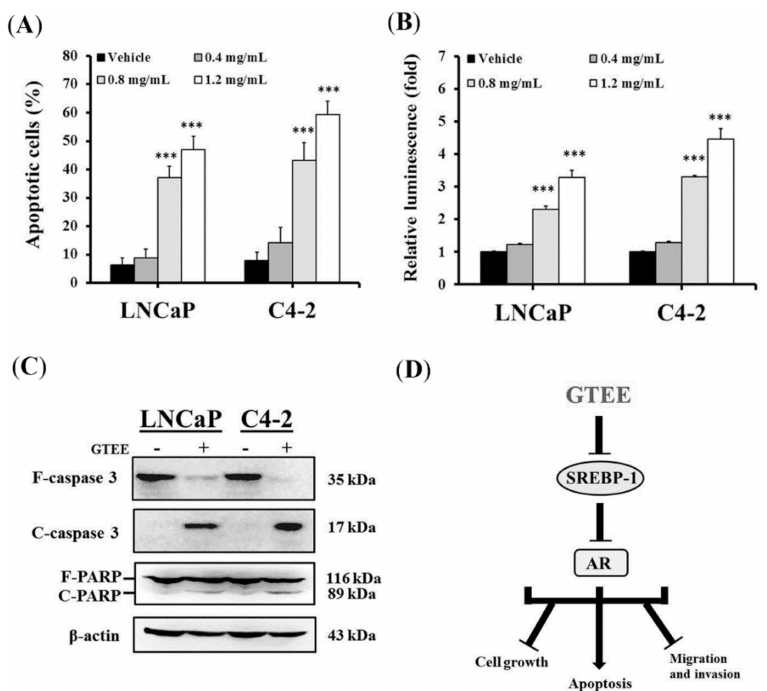
Figure 5. GTEE induces apoptosis through the caspase-dependent pathway in PCa cells. ( A ) After 24 h treatment with the vehicle (0.3% ethanol) or GTEE (0.4, 0.8 or 1.2 mg/mL), apoptotic cells (%) of LNCaP and C4-2 were determined by Annexin V-FITC staining analysis using flow cytometry. Data represented the mean ± SD of triplicate experiments. *** p < 0.001. ( B ) GTEE increased the caspase-3/7 activity in LNCaP and C4-2 cells with a dose-dependent manner. Luminescence of the caspase-3/7 activity was measured by an enzymatic activity assay. The relative luminescence (fold) was assigned as 1 in vehicle-treated cells. Results were shown as the mean ± SD of three independent experiments. *** p < 0.001. ( C ) Western blot analysis of caspase-3 and PARP proteins in PCa cells treated with vehicle (0.3% ethanol) or GTEE (1.2 mg/mL) for 20 h. GTEE greatly decreased full length (F)-caspase-3 as well as increased cleaved (C)-caspase-3 and C-PARP in LNCaP and C4-2 cells. β -actin was used as a loading control. ( D ) A schematic model of GTEE blocked the SREBP-1/AR axis to further suppress cell growth, migration, and invasion, and induce apoptosis in PCa cells was